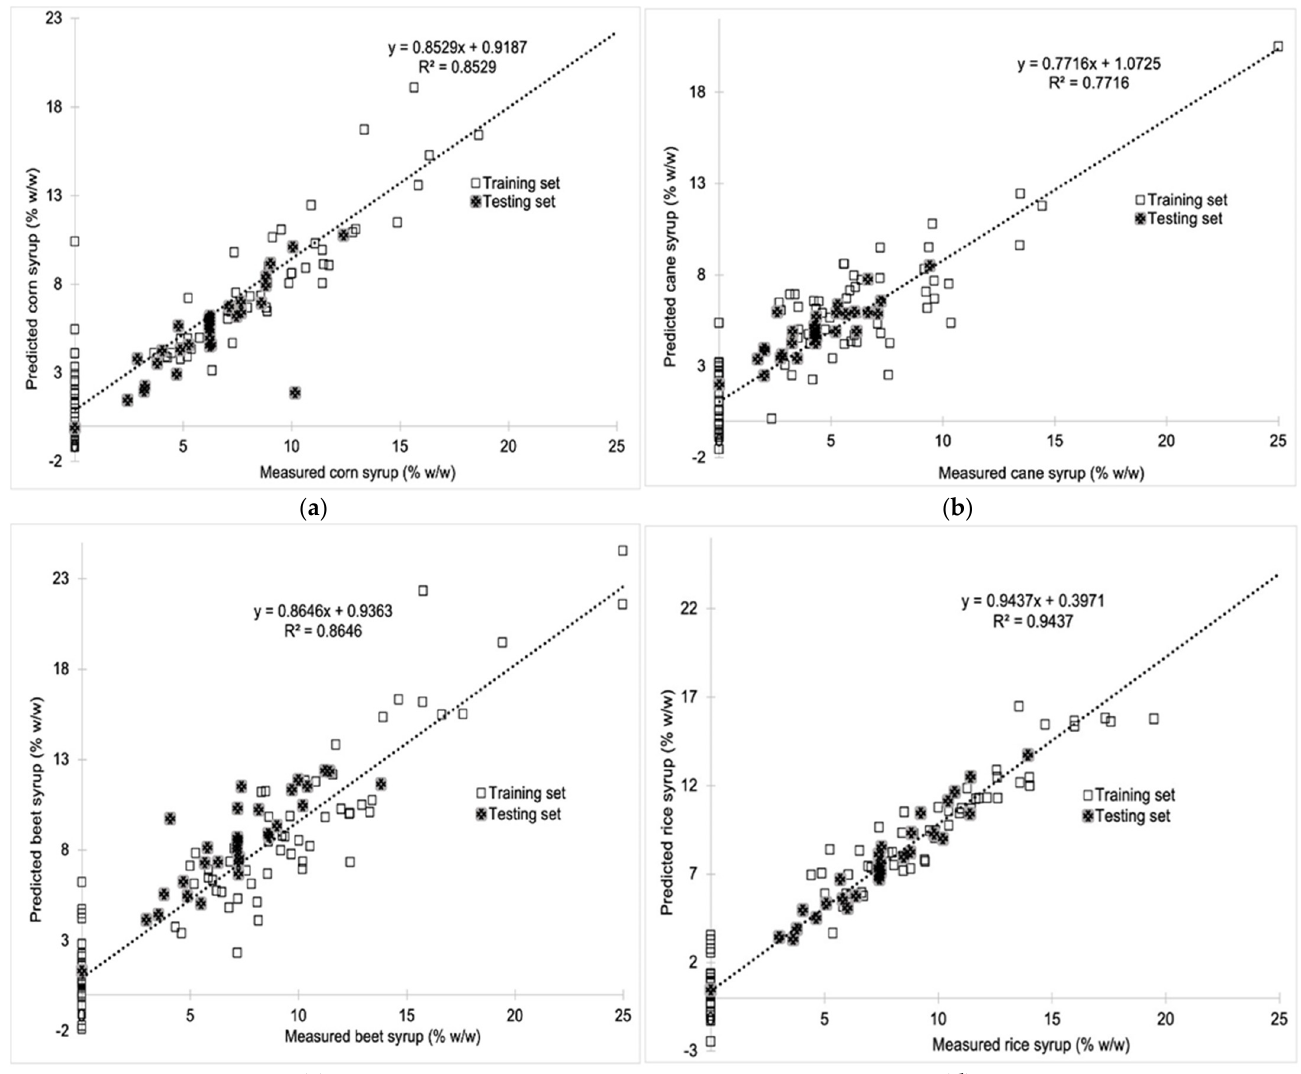
Figure 5. (a) Predicted vs. measured corn syrup (% w/w) using the first derivative signal processing technique in the specific spectral region for both the training and test sets (R 2 = 0.8529), ( b ) Predicted vs. measured cane syrup (% w/w) using the first derivative signal processing technique in the specific spectral region for both the training and test sets (R 2 = 0.7716), (c) Predicted vs. measured beet syrup (% w/w) using the first derivative signal processing technique in the specific spectral region for both the training and test sets (R 2 = 0.8646), (d) Predicted vs. measured rice syrup (% w/w) using the first derivative signal processing technique in the specific spectral region for both the training and test sets (R 2 =